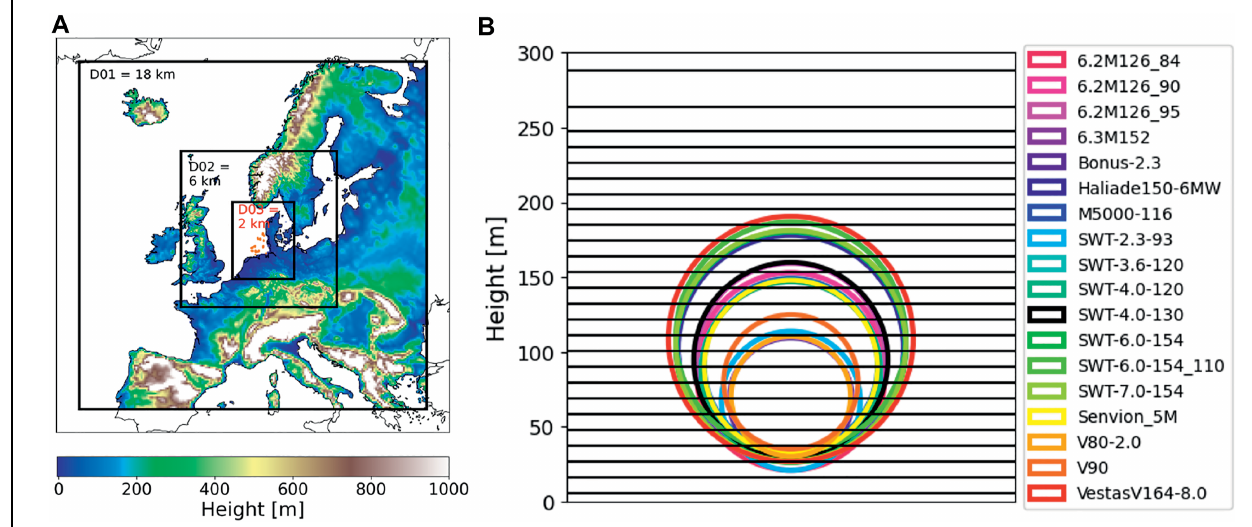
FIGURE 7 | (A) Orography as used in the respective three nested domains. Orange dots are offshore wind turbines in the innermost domain. (B) Height of the vertical model levels at mass coordinates. Circles indicate the rotor area for the different offshore turbines.